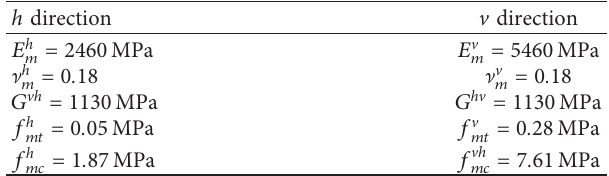
Figure 3: Geometry and load of the ETH Z¨urich walls tested by Ganz and Th¨urlimann [27]: (a) side view; (b) front view; (c) horizontal section. Table 1: W1 and W2 material properties [27].